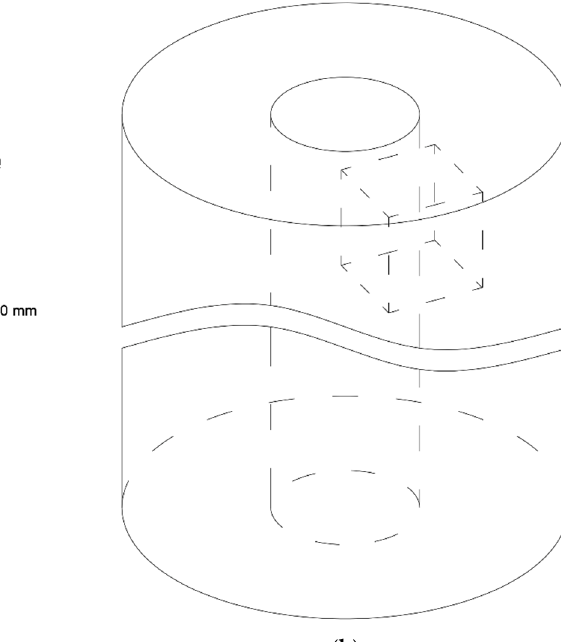
Table 5. List of used laboratory instruments.